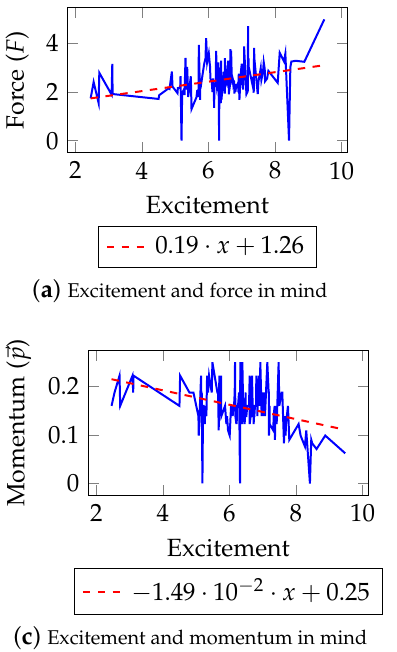
Figure 3. The dynamics of computed physical roller coaster based on increasing excitement and ( a ) Force in mind, ( b ) Energy in mind, and ( c ) Momentum in